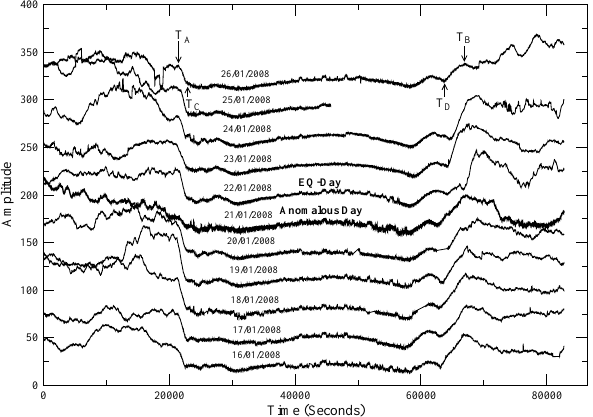
Fig. 5. The variation of the amplitudes of the VTX signal as a func- tion of time in seconds for 11 consecutive days: 16 January 2008 to 26 January 2008. Days are stacked after an amplitude shift of 30 units. The points T A T C , T D and T B are denoted in one of the days and DLPT= T C − T A and DLDT= T B − T D . On 22nd of January 2008, an earthquake occurred with magnitude 6.0. The data on 21st January, plotted with a thick line, clearly shows that on 21st January 2008, the DLPT and the DLDT are anomalously higher than those of the other days. The signal also shows that before and after 5 to 6 days of the ”earthquake day” the value of DLPT and DLDT is normal.